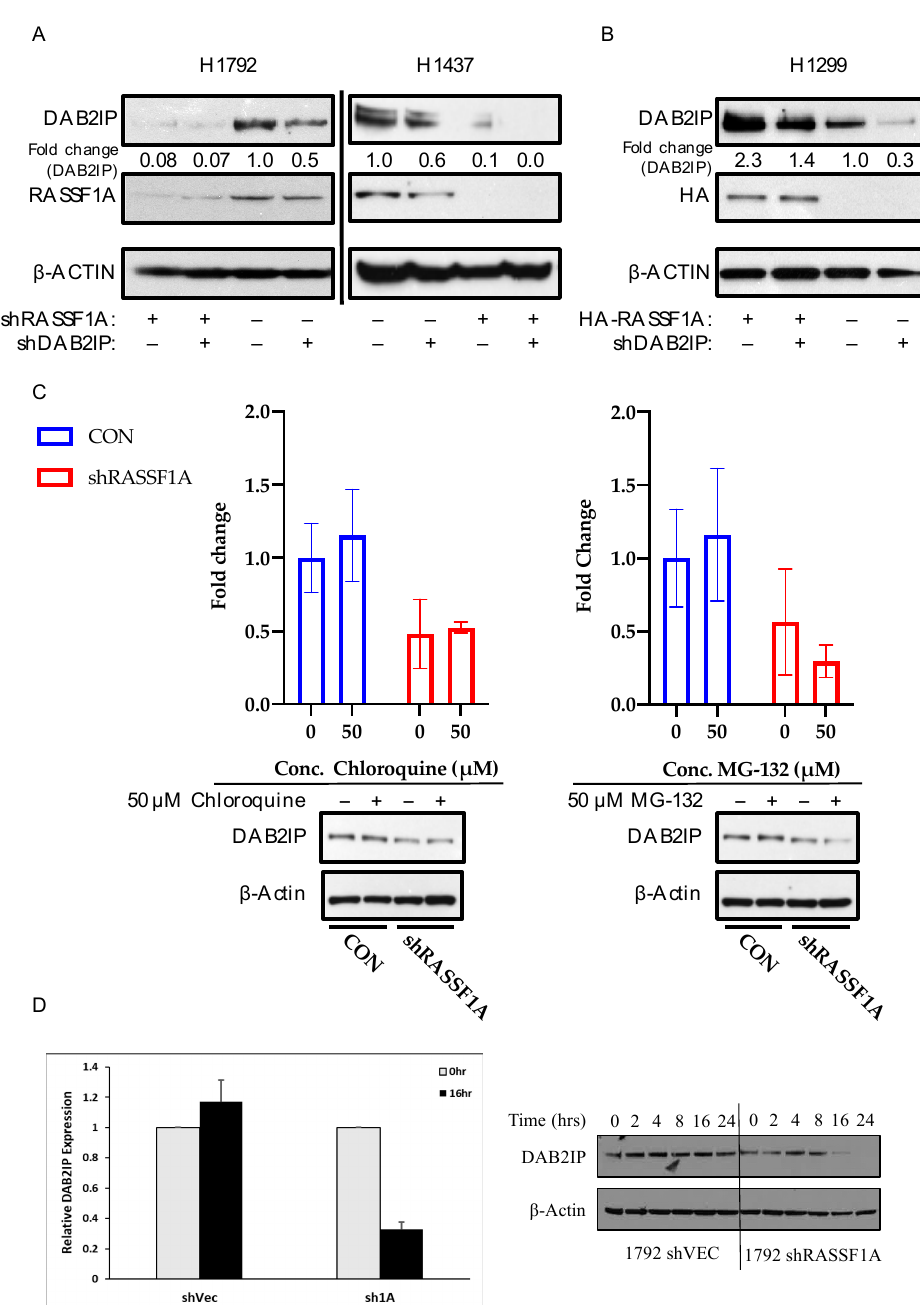
Figure 2. RASSF1A upregulates DAB2IP. ( A ) DAB2IP and RASSF1A expression in stably transfected NCI-H1792 and NCI-H1437 knockdown matched sets. Cells were grown to confluence and lysed in RIPA bu ff er. One hundred micrograms whole cell lysate was resolved per sample for Western blot analysis. ( B ) DAB2IP expression in NCI-H1299 HA-RASSF1A stably overexpressed system. Cells were grown to confluence and lysed in RIPA bu ff er. Twenty micrograms whole cell lysate was resolved per sample for Western blot analysis. ( C ) Chloroquine and MG-132 treatment in NCI- H1792 cells. Cells were treated with the above listed concentrations of chloroquine and MG-132, or an equivalent volume of DMSO for 24 or 4 h, respectively. Cells were lysed in RIPA bu ff er. Fifty micrograms whole cell lysate was resolved per sample. DAB2IP expression was determined by Western blot and quantified via densitometry. Reported as mean ± s.e., n = 2. ( D ) NCI-H1792 cells stably transfected with shRNA against RASSF1A or control vector were treated with cycloheximide at 25 µ g / mL to inhibit protein synthesis and the relative stability of endogenous DAB2IP measured by Western blot over a time course. At time 16 h the results were quantified relative to time zero. Data are an average of two experiments. A representative blot is shown in the right